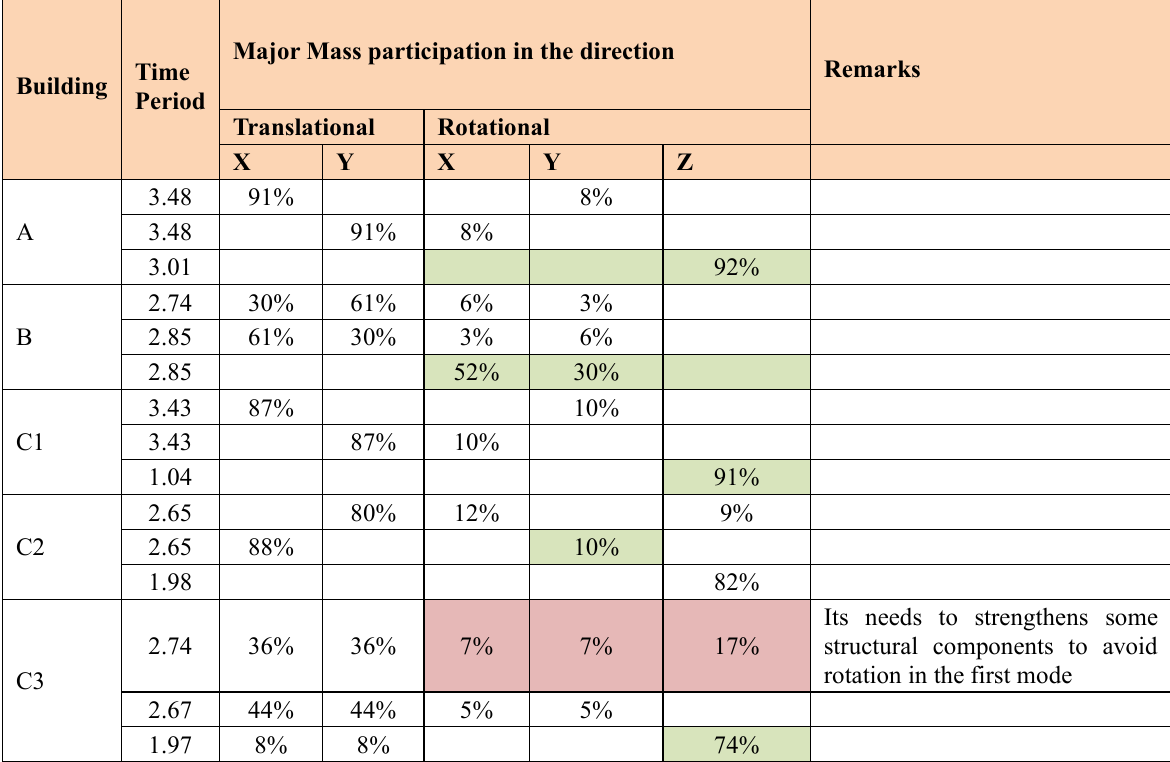
First Time period obtained from modal analysis (Analysis approach 02). Building A B Time period from modal analysis Modal Analysis Result for first 03 modes of the